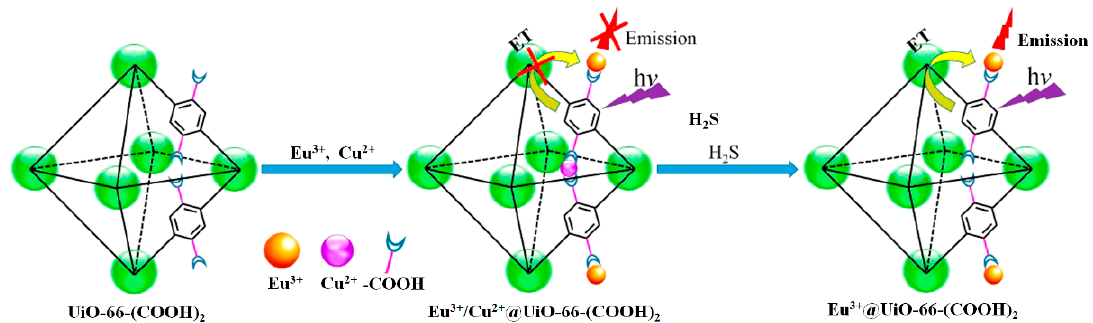
Figure 6. The fluorescence detection mechanism of the MOF Eu 3 + / Cu 2 + @UiO-66-(COOH) 2 system for H 2 S. Reproduced with permission from [83]. Copyright American Chemical Society, 2016.